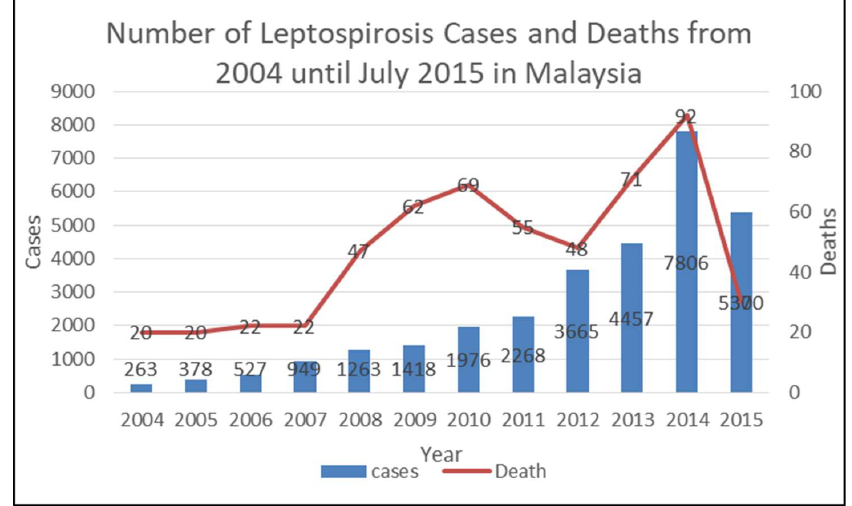
Figure 1. Summary of the number of leptospirosis cases and associated deaths in Malaysia from 2004 to July 2015 [26].